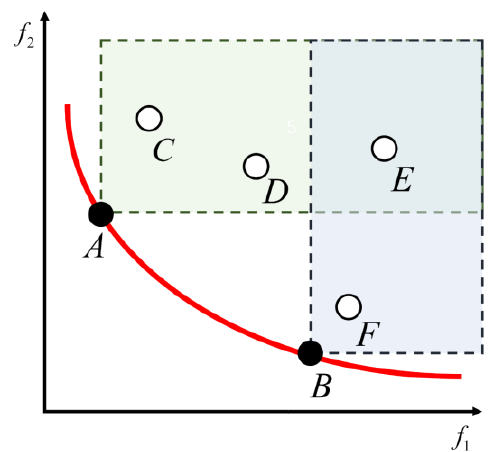
Figure 8. Schematic diagram of Pareto dominance relation (A and B: Pareto non-dominated solution; C, D, E, and F: Dominated solution).